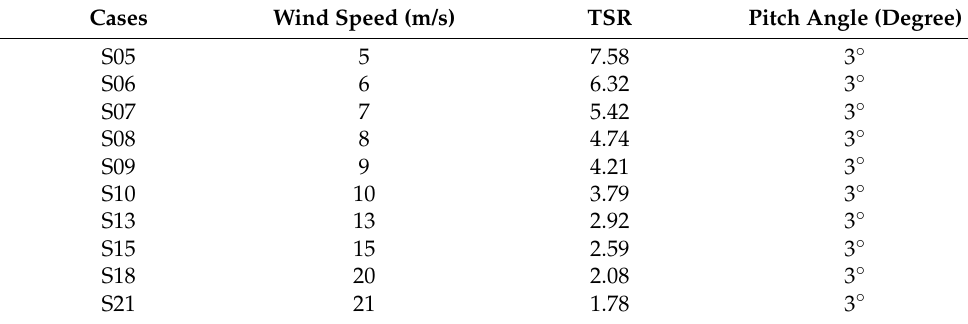
Table 5. Test cases used for the NREL phase VI wind